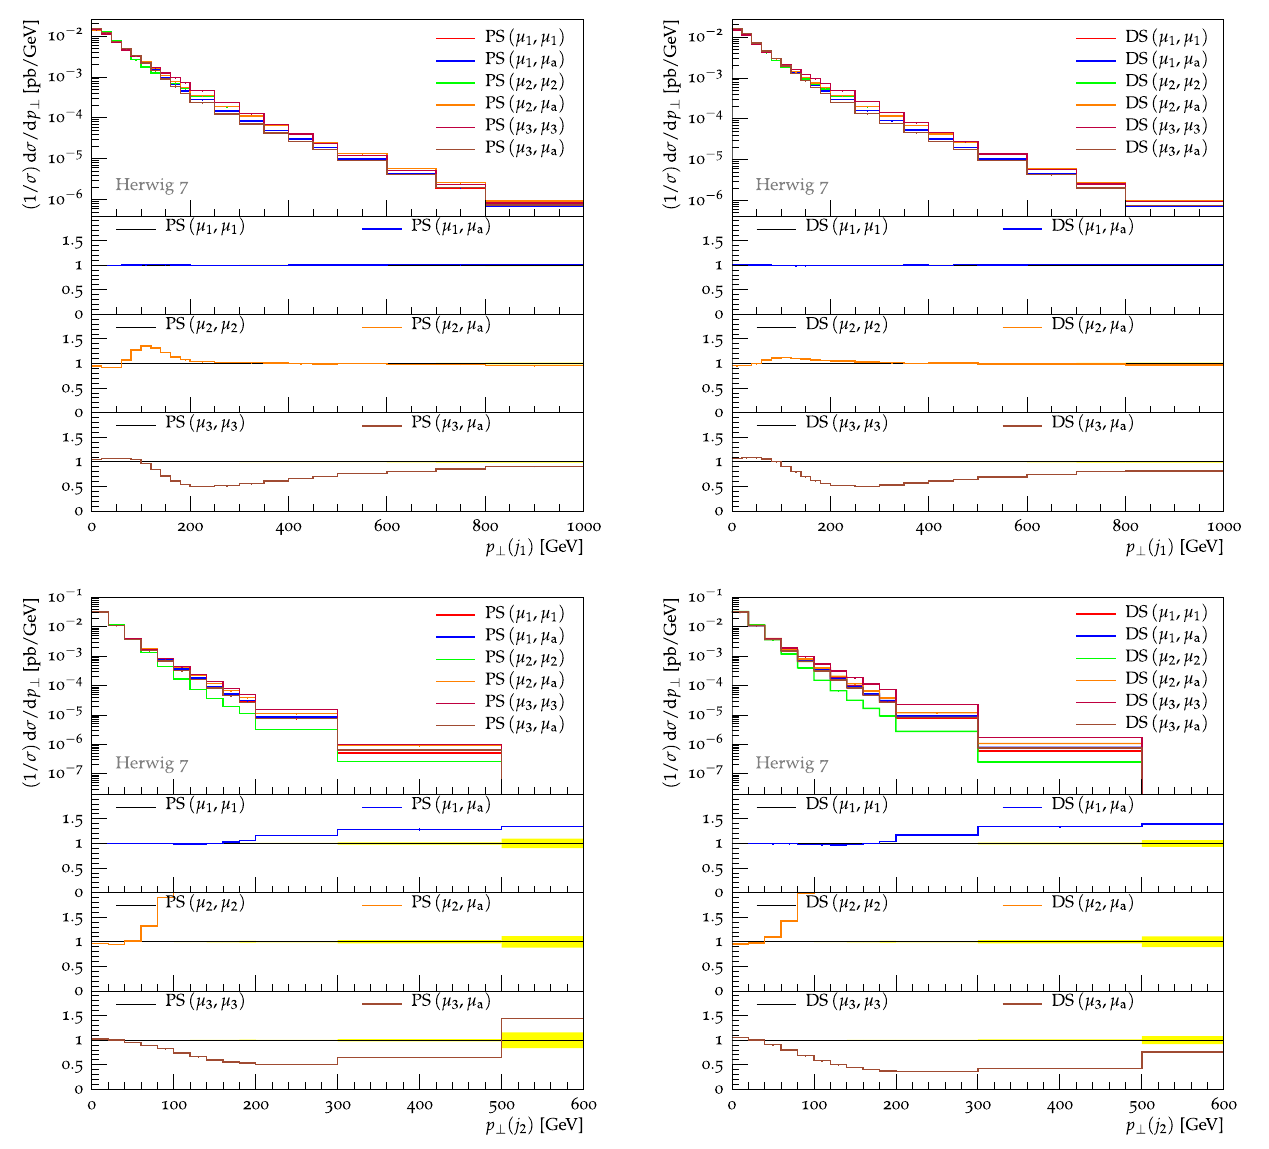
are specified in the format (μ H , Q ⊥ ) and each of the scale choices is defined in the text. From top to bottom, left to right, we present the p ⊥ spectra of the hardest and second hardest jets, produced with the angular-ordered and dipole shower